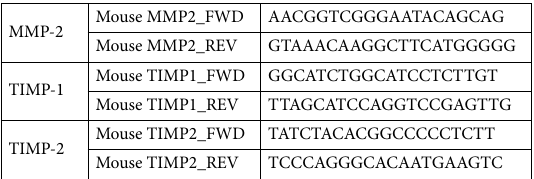
Table 1. Primers designed for